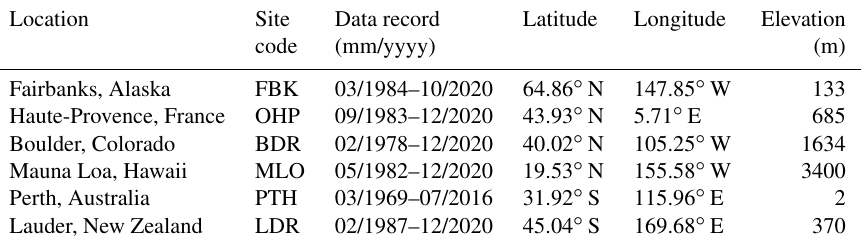
Table 1. NOAA Dobson Umkehr data information: Name of the station, WMO code, dates of the record (month and year), and geolocation of the ground-based